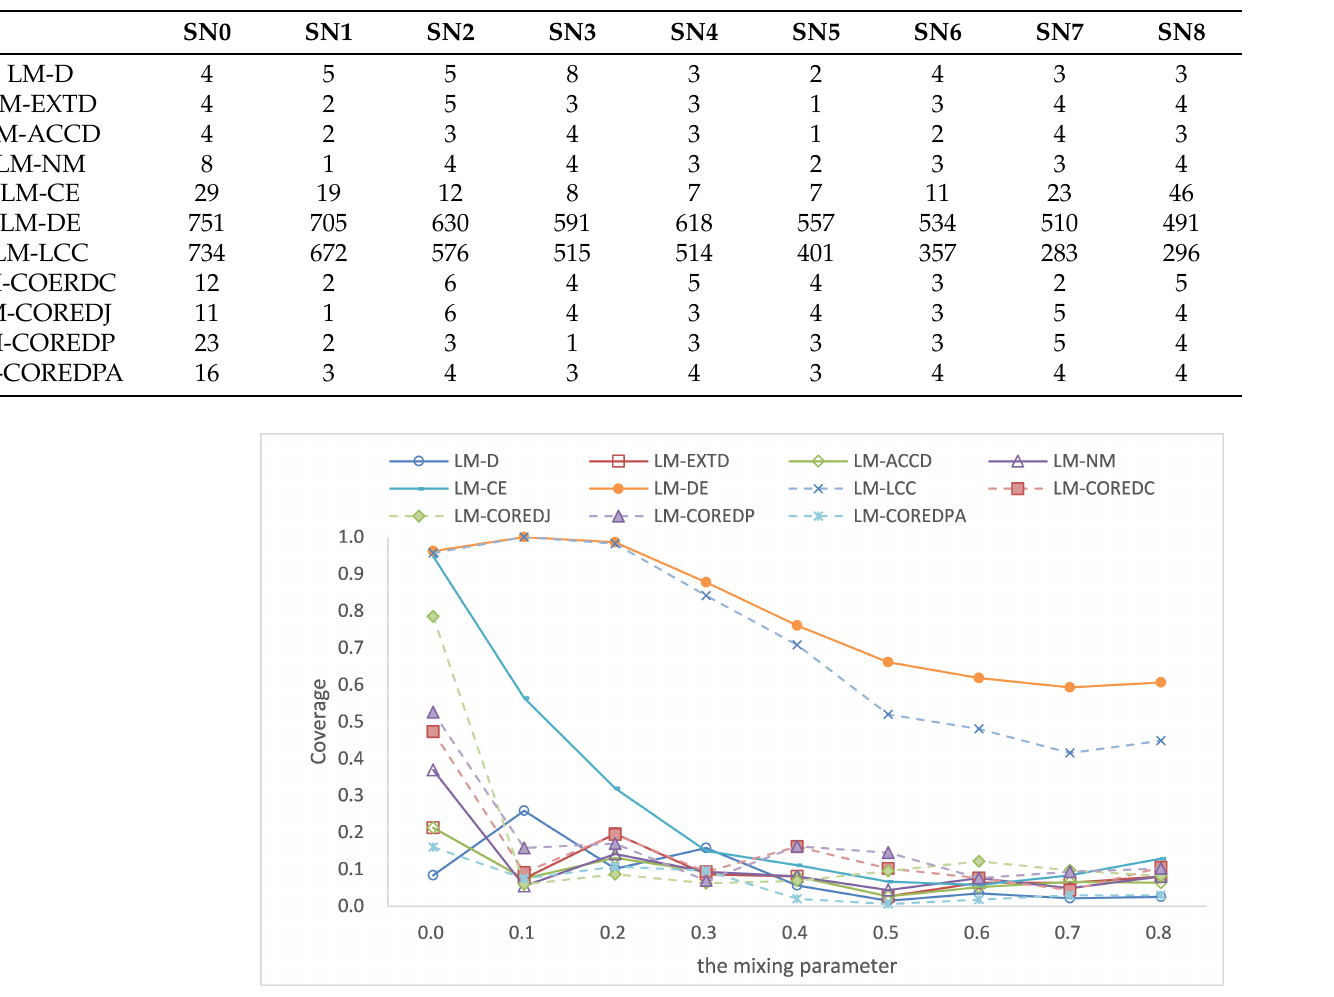
Table 10. The number of seeds chosen by different algorithms.